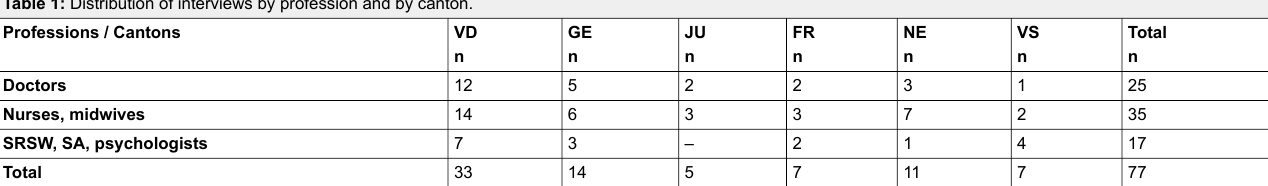
Table 1: Distribution of interviews by profession and by canton. Professions /